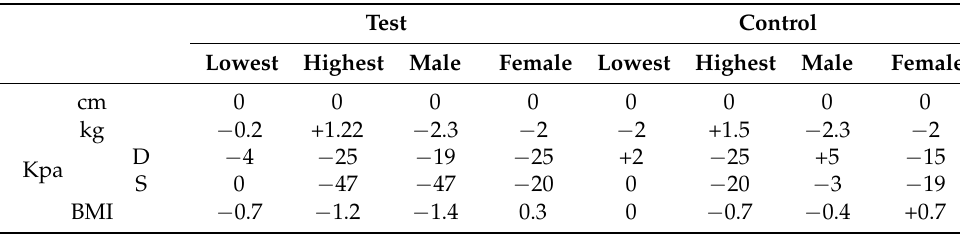
Table 7. Comparison of body composition data between experimental and control groups. Test Control